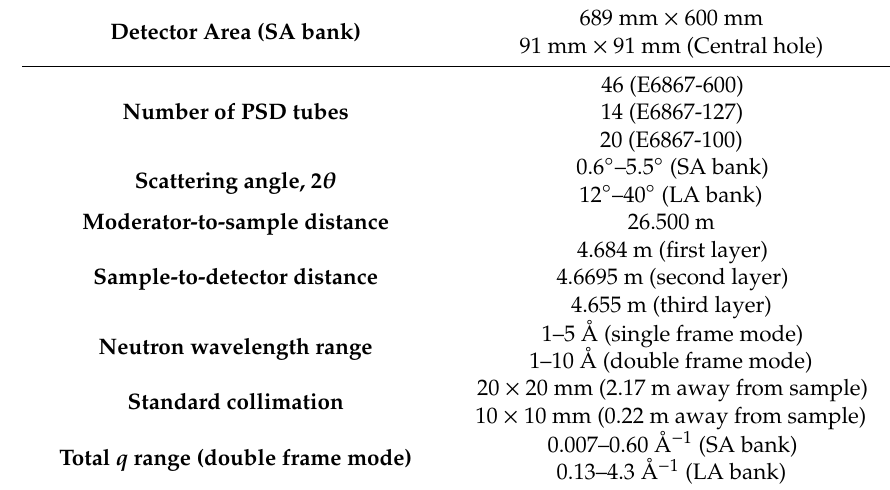
Table 2. Specification of the SANS detector on